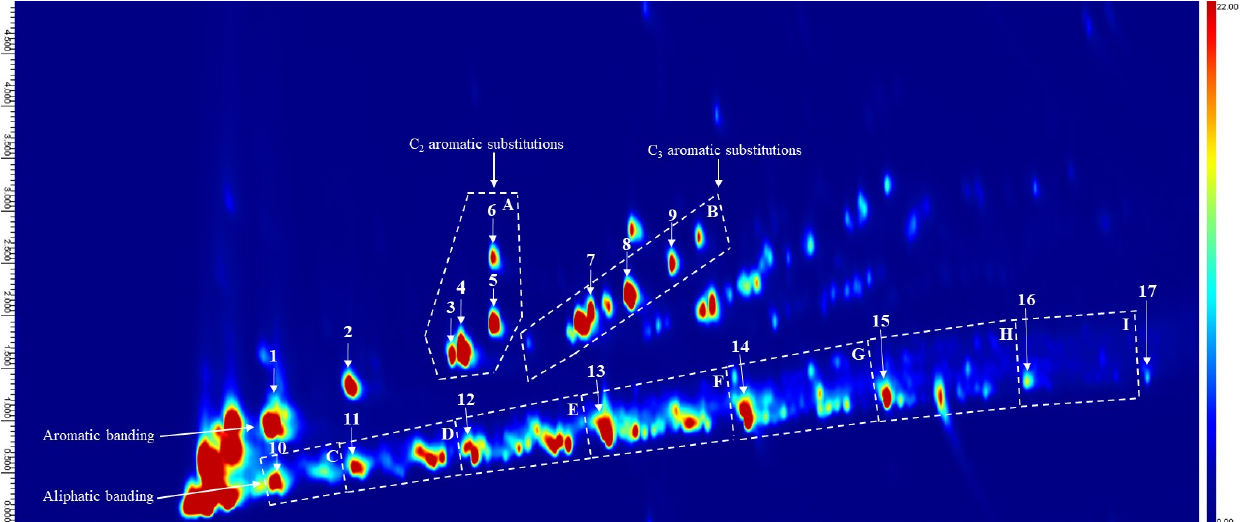
Figure 2. An annotated chromatogram displaying the speciated VOC-IVOCs. Chromatogram axis, x is the first dimension separation (boiling point, increasing from left-to-right), y is the second dimension separation (polarity, increasing from bottom-to-top). Colour scale represents peak intensity, increasing from blue to red. Letters refer to compound groupings; A is the single-ring aromatics with two carbon substitutions, B is the single-ring aromatics with three carbon substitutions, C to I is the C 7 to C 13 aliphatics grouped by carbon number (i.e. C is the C 7 aliphatics, D is the C 8 aliphatics etc.). Numbers refer to individual compounds; 1 is benzene, 2 is toluene, 3 is ethyl benzene, 4 is meta/para- xylene (co-elution), 5 is ortho-xylene, 6 is styrene, 7 is 1,3,5-trimethyl benzene, 8 is 1,2,4-trimethyl benzene, 9 is 1,2,3-trimethyl benzene, 10 is heptane, 11 is octane, 12 is nonane, 13 is decane, 14 is undecane, 15 is dodecane, 16 is tridecane, and 17 is tetradecane (not quantified). Aromatic and aliphatic banding often observed with this technique are shown (cf. Hamilton and Lewis, 2003, and Dunmore et al., 2015). The start and end of each aliphatic grouping is marked by the lower and higher carbon number n -alkane (i.e. nonane marks the start of the C 9 aliphatic grouping, decane marks the end of this